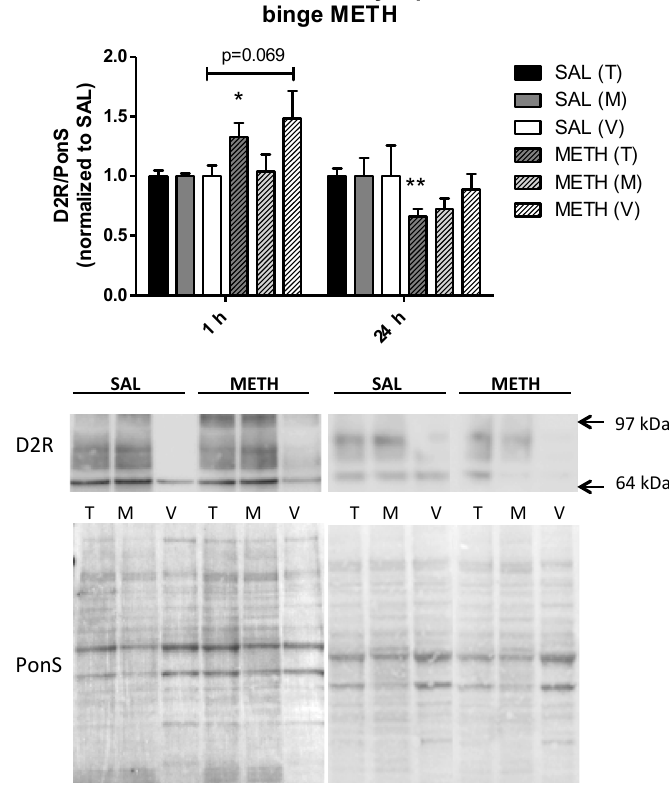
Figure 5. The effect of binge intraperitoneal (i.p.) METH on the immunoreactivity of pre-synaptic dopamine D2 autoreceptor (D2S) in striatal synaptosomal fractions. Binge METH (4 × 10 mg/kg, every 2 h, i.p.) increased D2 receptor immunoreactivity at 1 h in total synaptosomal fraction (+32%, * p < 0.05) and decreased D2 receptor immunoreactivity at 24 h in all three fractions, total, membrane-endosomal, and cytosol-vesicular fraction ( − 34% ( ** p < 0.01), − 28%, and − 11%, respectively). A trend for an increase in D2S immunoreactivity was observed in cytosol-vesicular fraction (+48%, p = 0.069). Abbreviations: M, membrane fraction; METH, methamphetamine; PonS, Ponceau S; SAL, saline; T, total fraction; V, vesicular